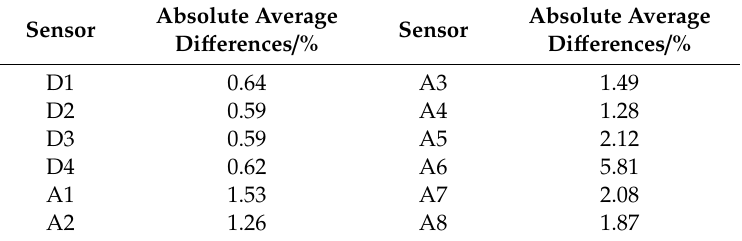
Table 3. Absolute average di ff erences of di ff erent sensors.